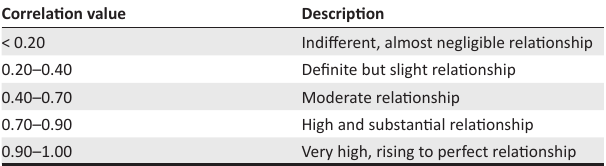
TABLE 6 : Construct correlation strength